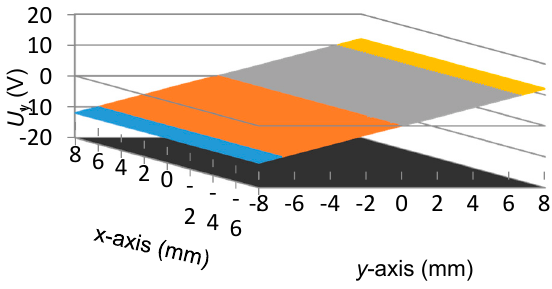
Figure 9. Scanning result of U y .